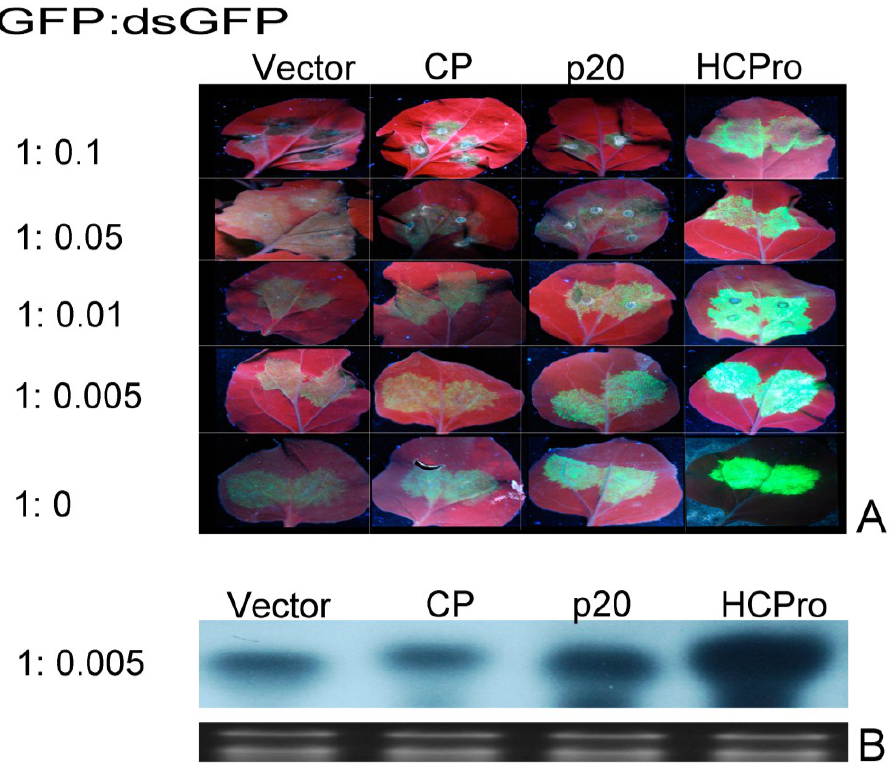
Figure 5. Effect of low levels of GFP dsRNA inducer on suppression of local GFP